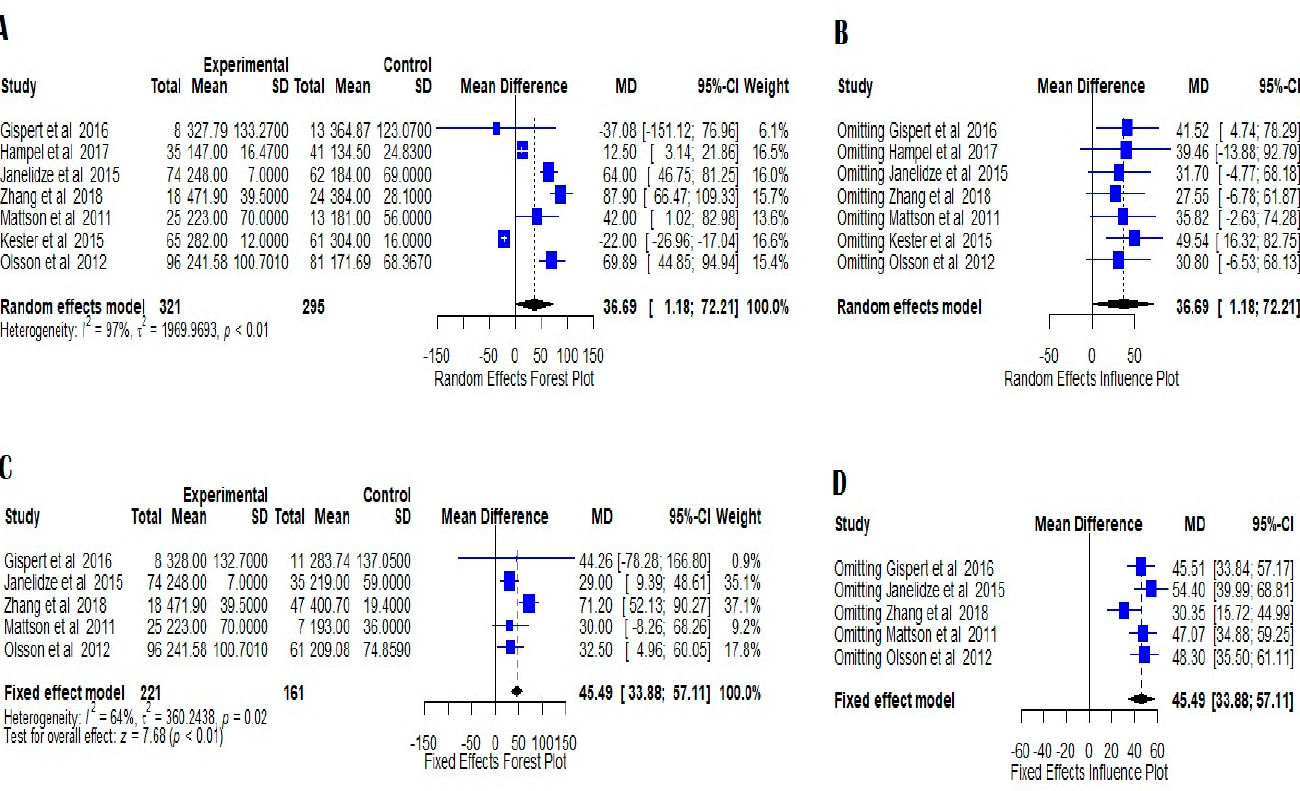
Figure 4. Forest plots of YKL-40 CSF levels in AD versus MCI; ( A ) and AD versus MCIAD; ( C ) indicating high heterogeneity in random (AD versus MCI) and fixed effects models (AD versus MCIAD). The figures indicate the means, standard errors (pg/mL), 95% confidence intervals, and weighted mean differences for each study included in this meta-analysis. For each comparison, a supplemental random effects influence plot was designed to further evaluate the possible publication bias when omitting each of the included studies; ( B , D ) mean differences and 95% confidence intervals being calculated in each situation. The standardized mean differences between patients and controls are represented as squares whose sizes are proportional to the sample sizes. The whiskers represent the 95% confidence intervals. The diamonds represent the pooled estimate based on the random-effect model with the center representing the point estimate and the width indicating the assessed 95% confidence interval. The heterogeneity indicators (I 2 , τ 2 , p ) are presented below each random effects Forest plots.